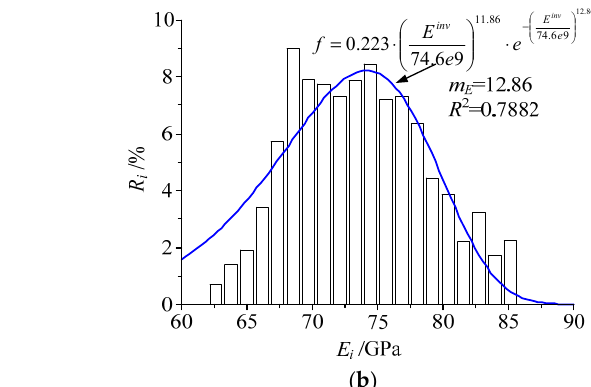
Figure 8. ( a ) Strain field; ( b ) Young’s modulus field and ( c ) Poisson field of the sandstone under axial stress of 26 MPa.